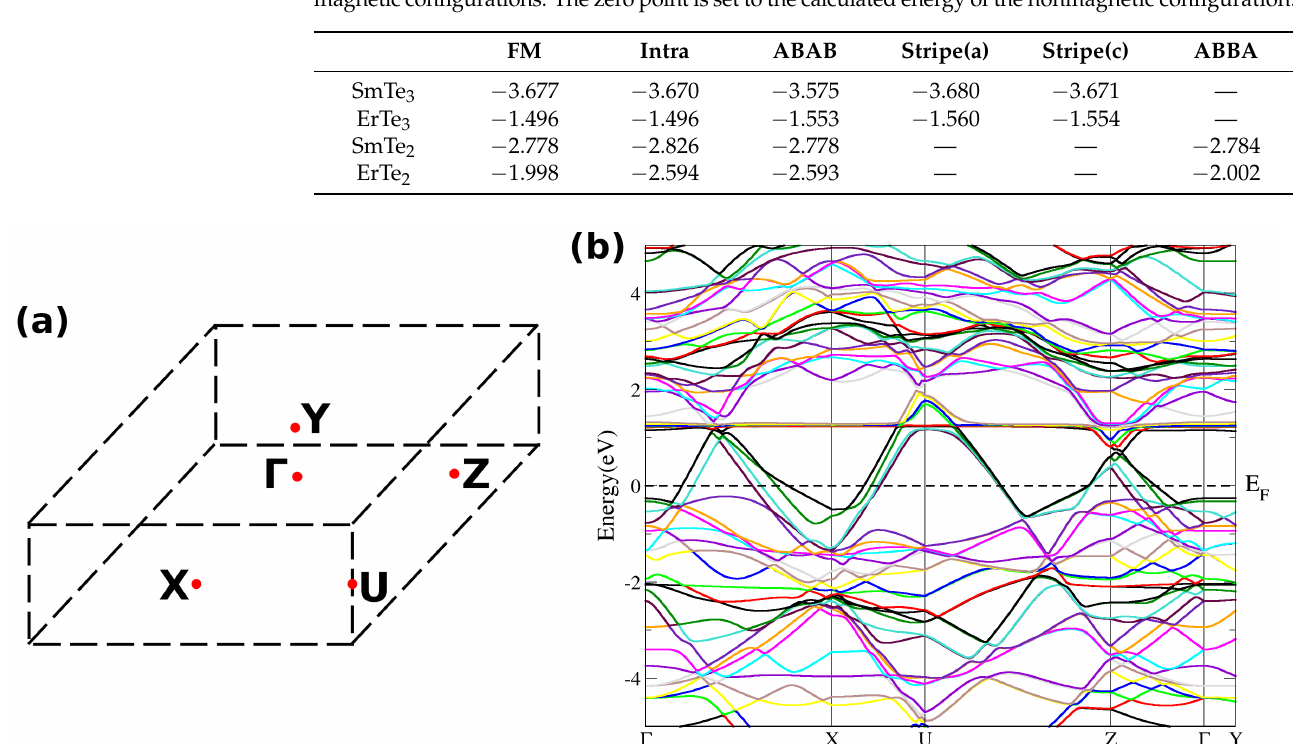
Table 2. The calculated energies (eV), per rare-earth atom, of the various ferromagnetic and antiferro- magnetic configurations. The zero point is set to the calculated energy of the nonmagnetic configuration.